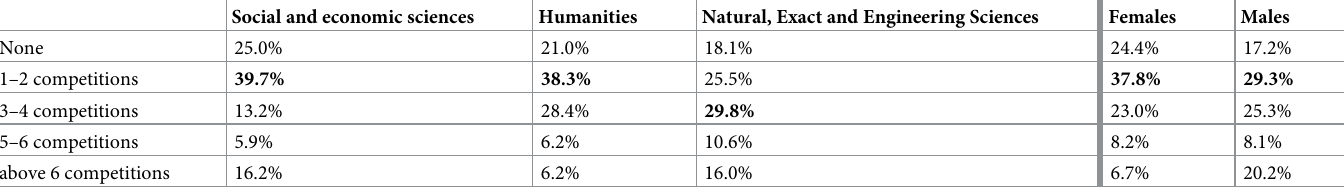
Table 2. Number of competitions in which respondents participated in the last 5 years by respondent’s fundamental area of interest and by their gender. Social and economic sciences Humanities Natural, Exact and Engineering Sciences Females